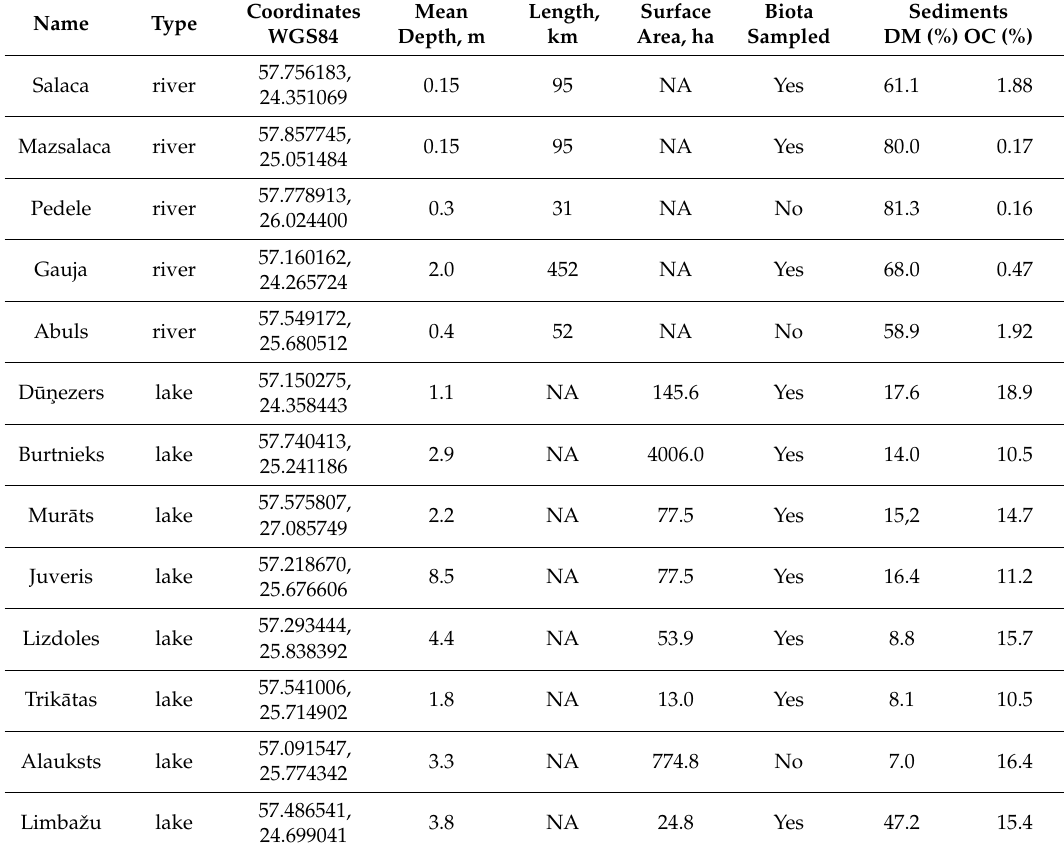
Table 2. Description of the investigated water bodies and sediment